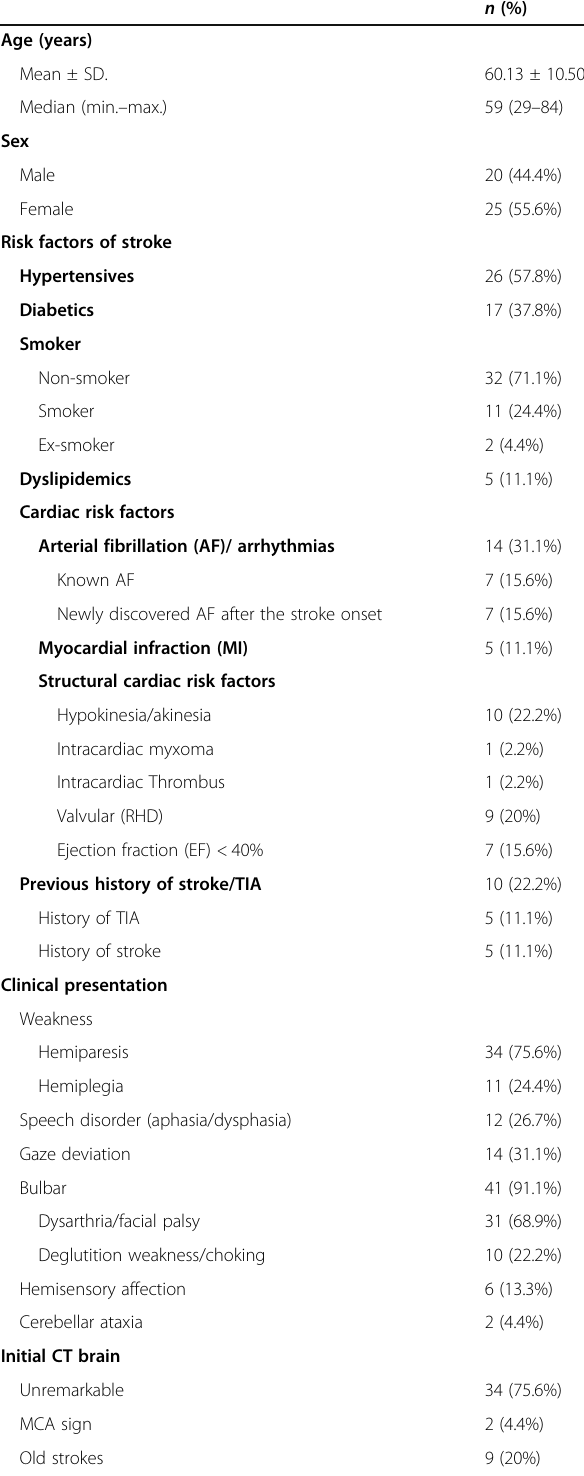
Table 1 Demographic data, stroke risk factors, and clinical presentation in the study sample ( n =